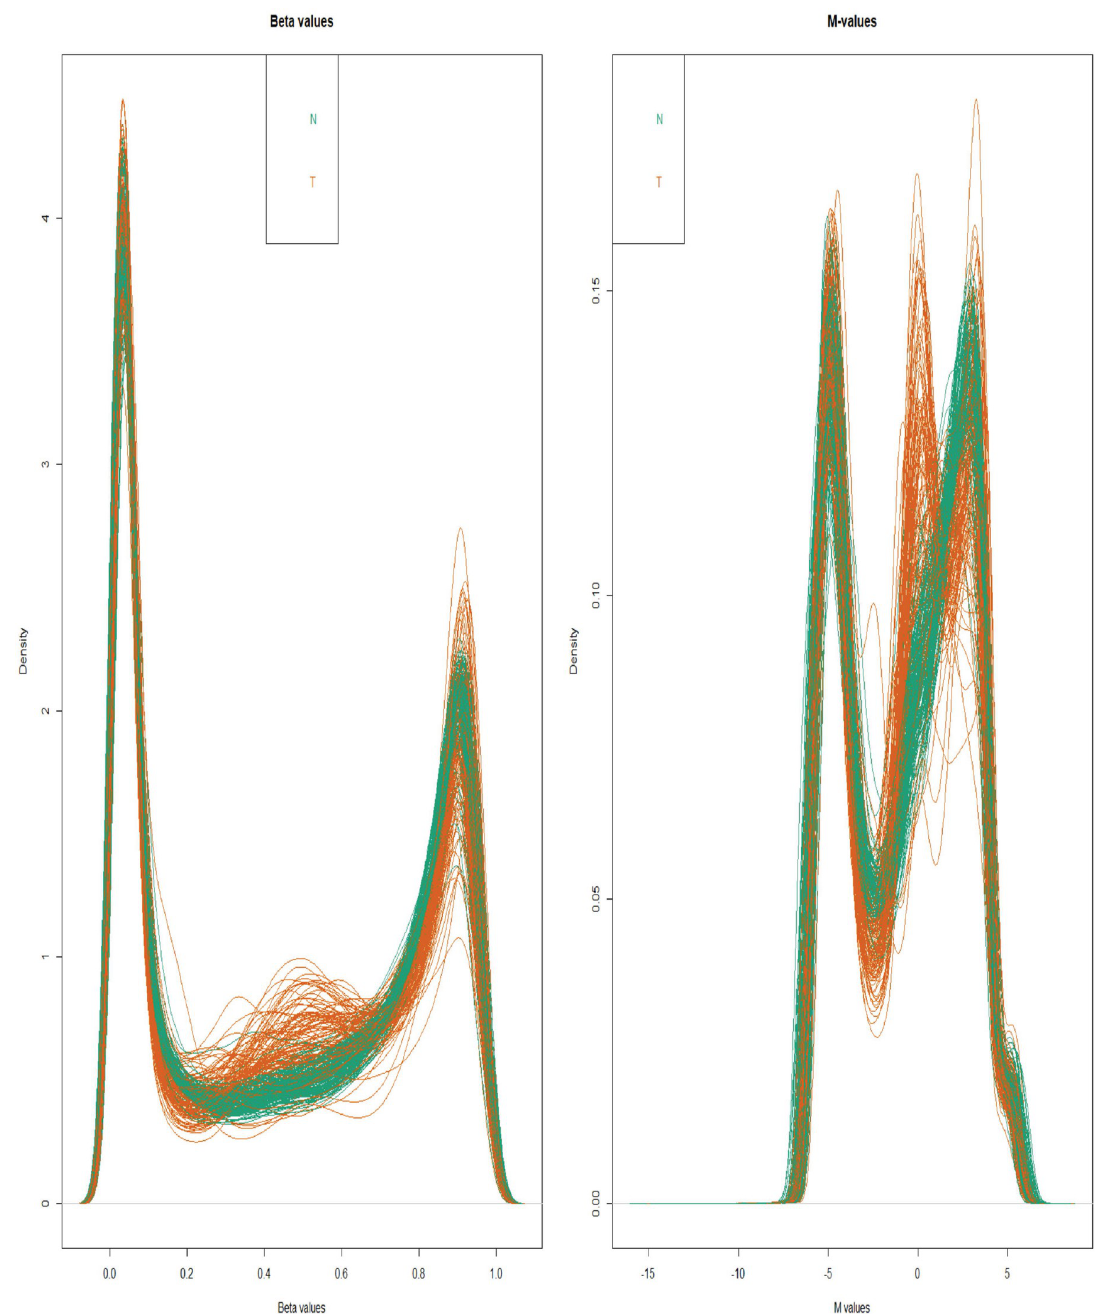
Fig 3. Comparison between Beta and M values. Beta and M values are usually used for visualization and statistical calculations, respectively.